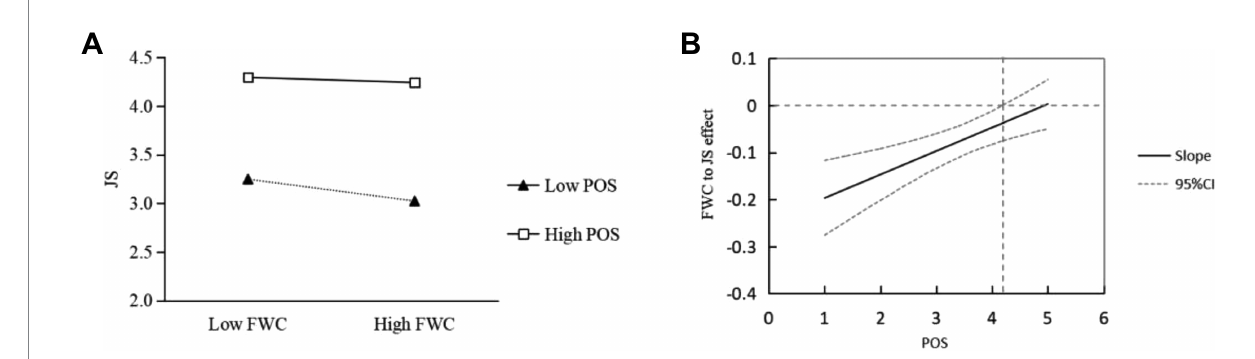
FIGURE 5 Moderating effect of POS on the relationship between FWC and JS A : Simple slope test of moderating effect B : Johnson-Neyman analysis of moderating effect.